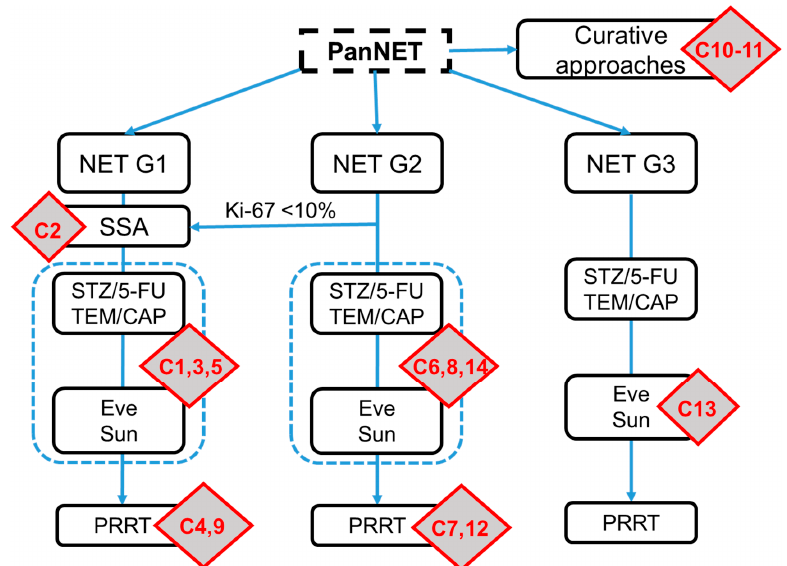
Figure 2. Allocation of the case reports to the current ESMO guidelines on gastroentero-pancreatic (GEP)-NETs. The C refers to the corresponding question in the survey and the red boxes illustrate the position of the questions within the ESMO therapy schema. The scheme was adapted based on the original version of the ESMO guidelines. SSA, somatostatin analogs; Eve, everolimus; Sun, sunitinib.